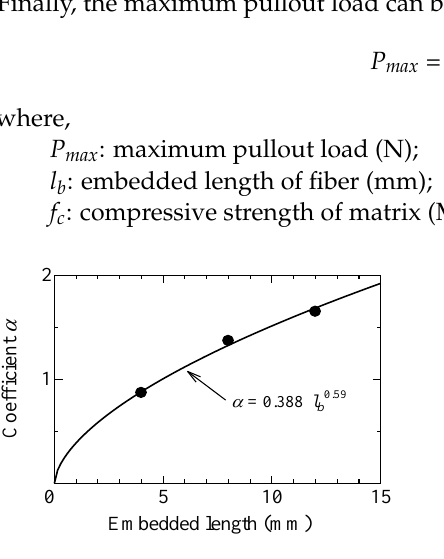
Figure 14. Relationship between coefficient α and embedded length.